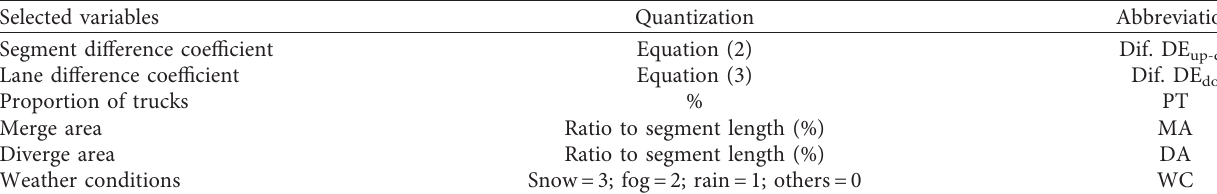
Table 2: Variable